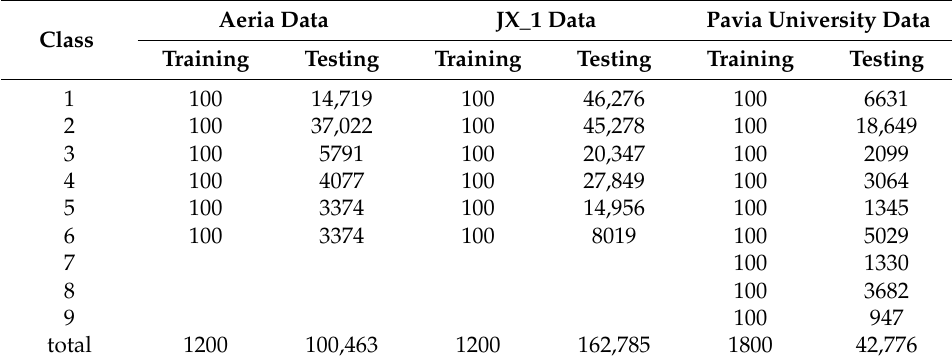
Table 1. Numbers of the initial training and testing